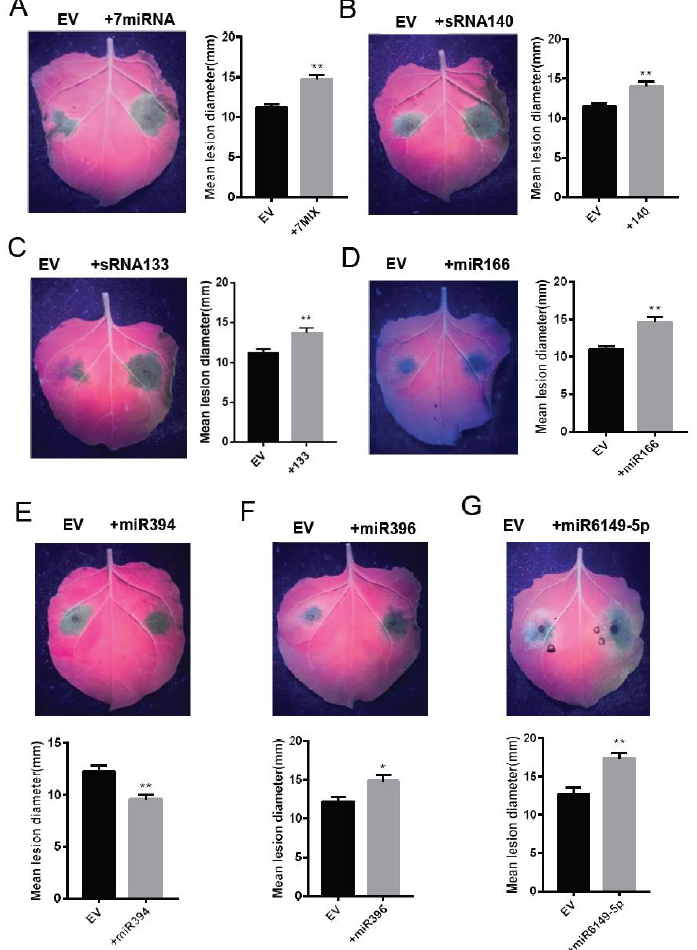
Figure 5. Transient expressing miRNAs to verify their function in regulation of late blight resistance. ( A ) 7miRNA means tandem expression vector containing seven miRNA